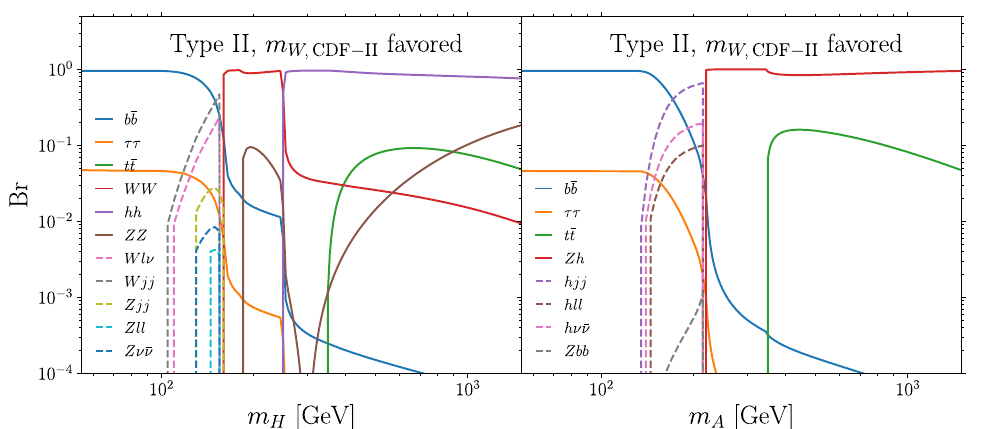
Fig. 8 Branching ratios for H (left) and A (right) in the type-II HTM for λ 2 = λ 3 = λ 4 = 0, v (cid:4) = 1 GeV, with a mass spectrum explaining the CDF-II m W measurement. Branching ratios for two-body (three-